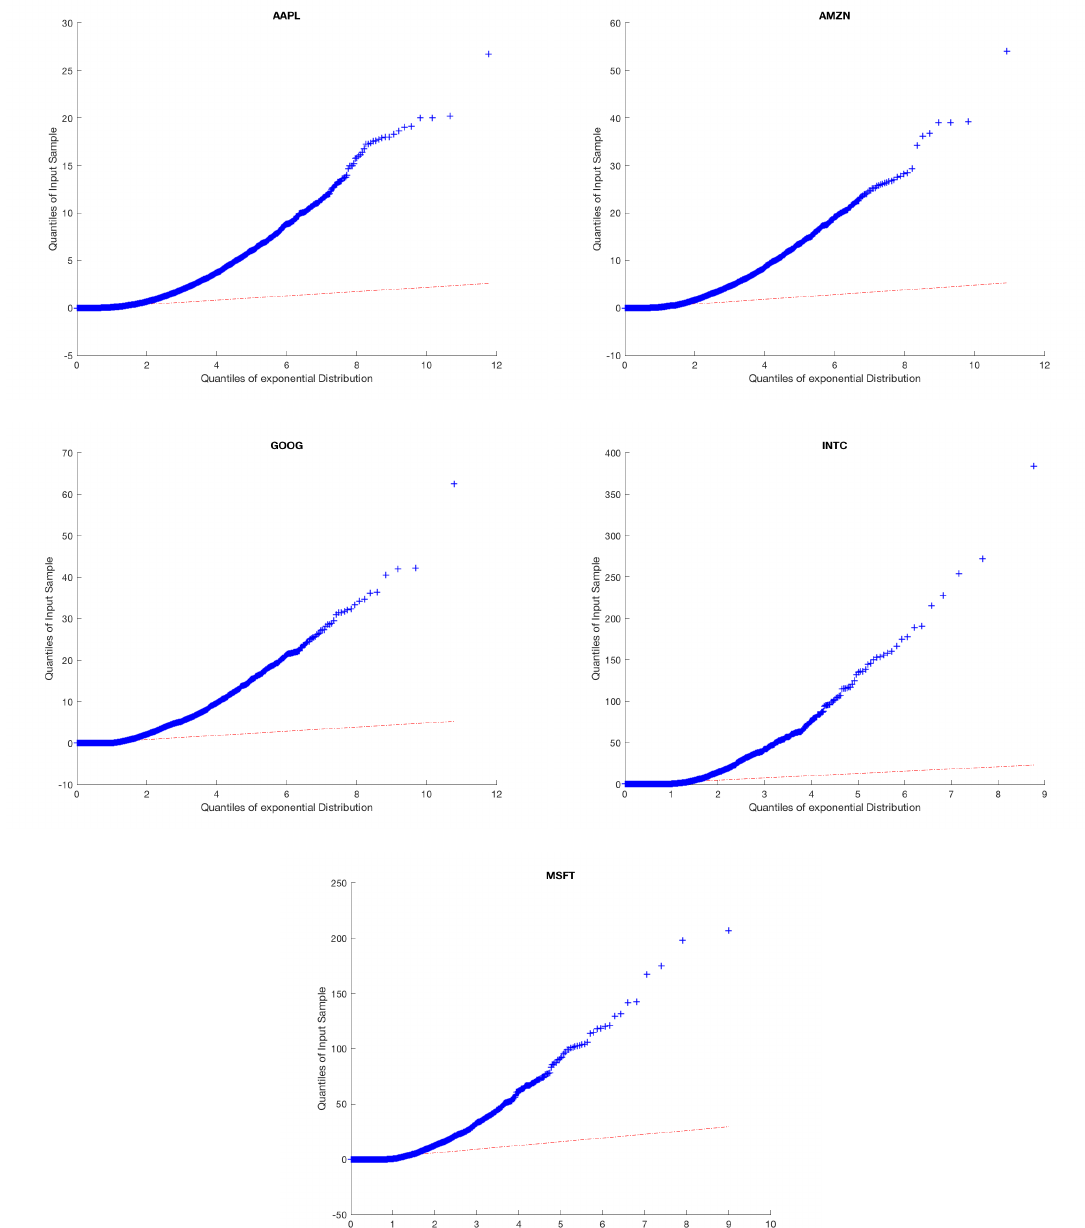
Figure 1. Above, we provide a quantile-quantile plot of our empirical inter-arrival times against a Poisson process for each of the five stocks. We see that the inter-arrival data does not fit the expected curve, providing evidence that the underlying arrival process is not